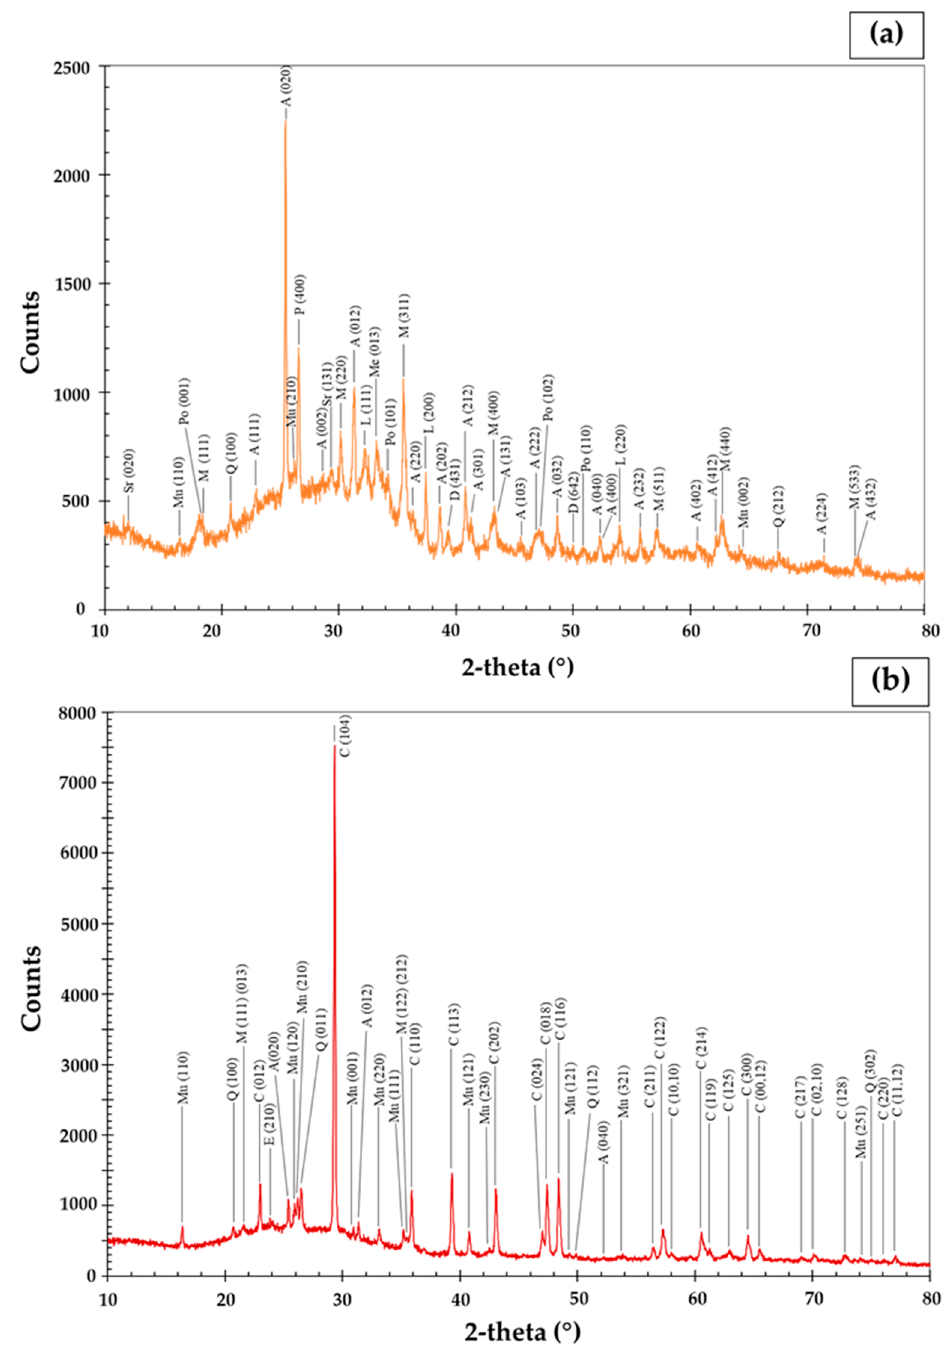
Figure 8. X-ray di ff raction patterns of ( a ) fly ash sample and ( b ) bulk cenospheres Figure 8. X-ray diffraction patterns of ( a ) fly ash sample and ( b ) bulk cenospheres showing mineral phases identified in the abbreviations: A—anhydrite, C—calcite, CS—calcium silicate, E—ettringite, L—lime, M—magnetite, Me—merwinite, Mu—mullite, P—potassium magnesium silicate, Po—